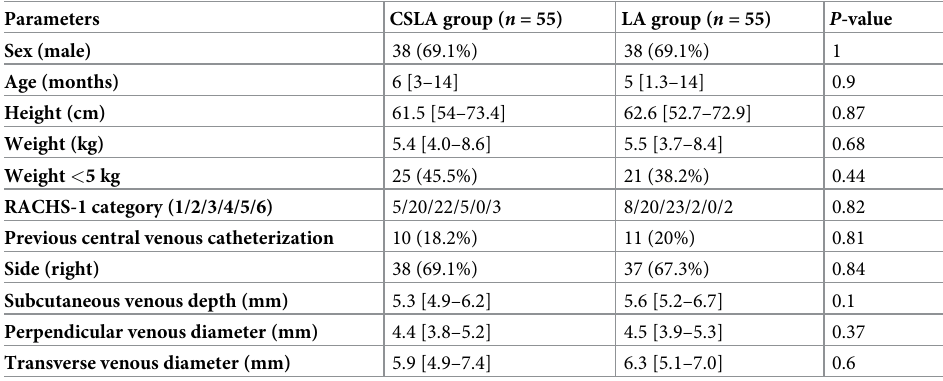
Table 1. Patients’ demographic and clinical